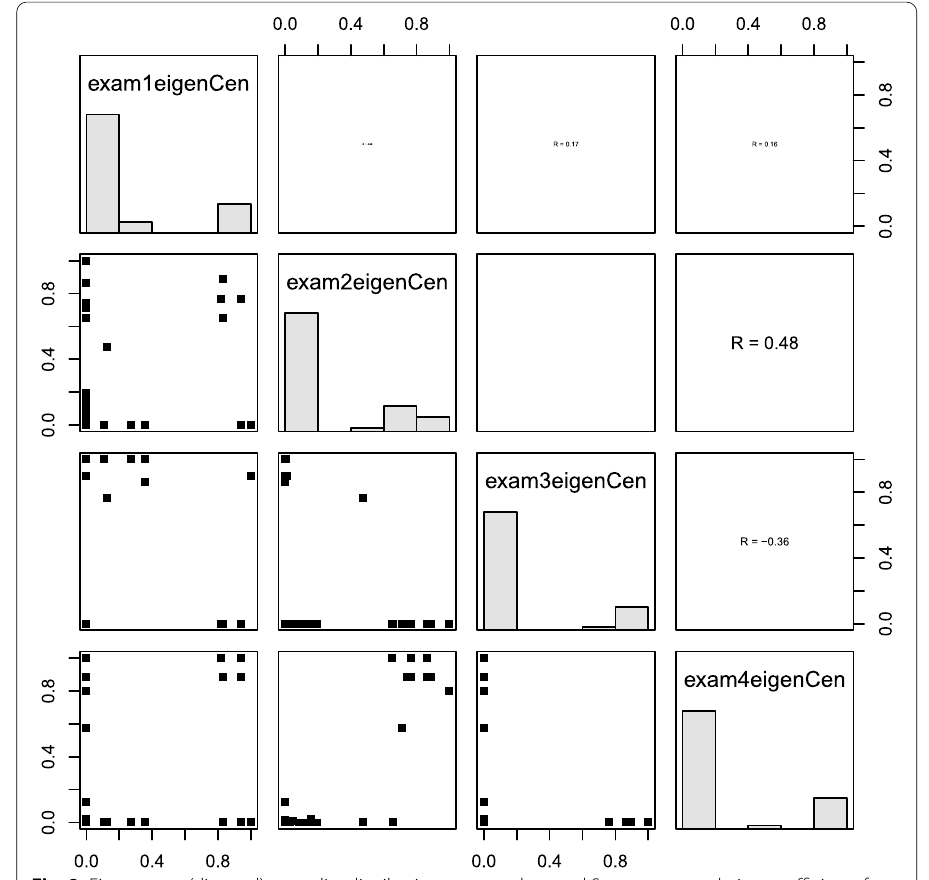
Fig. 8 Eigenvector (directed) centrality distributions, scatterplots, and Spearman correlation coefficients for the Fall 2015